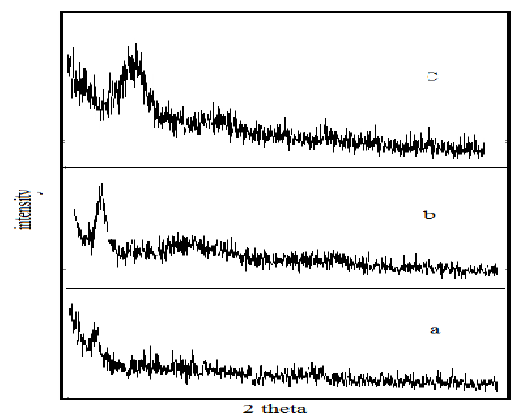
Fig.4. SEM photograph of compound 1 nano-structure prepared by thermal treatment of compound 1 with oleic acid at 453 K.